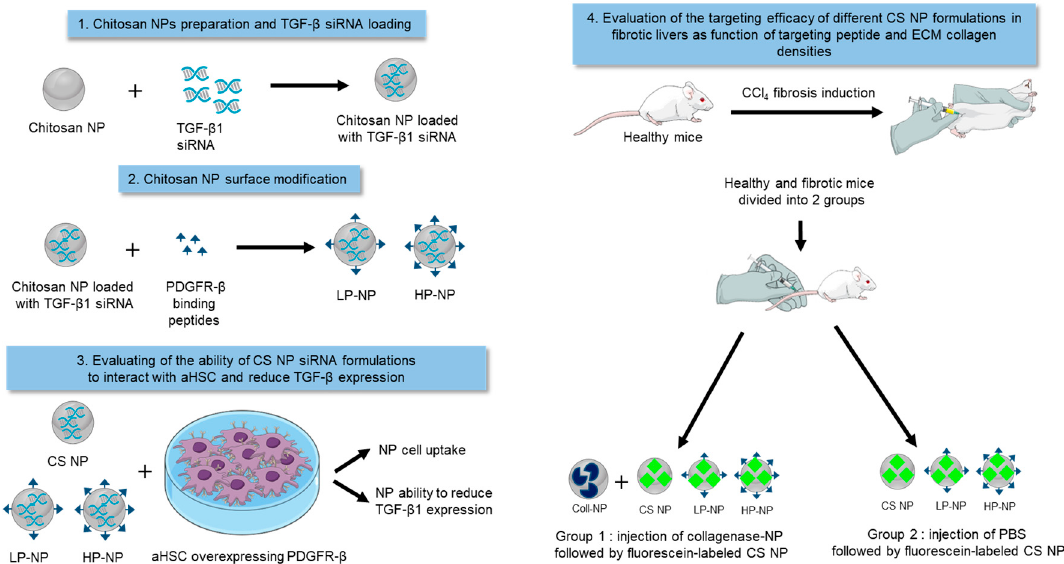
Figure 1. Schematic representation of the experimental workflow.